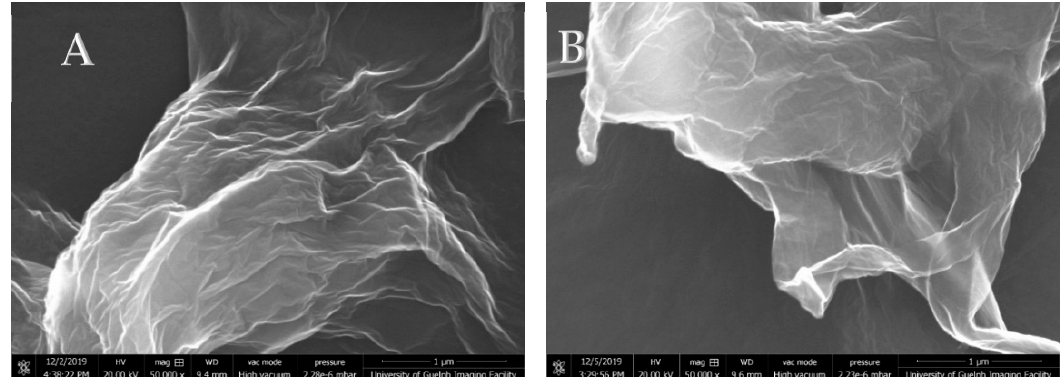
Figure 1. Scanning electron microscopy (SEM) images of ( A ) graphene oxide; ( B ) fluorinated graphene oxide (F ‐ GO).